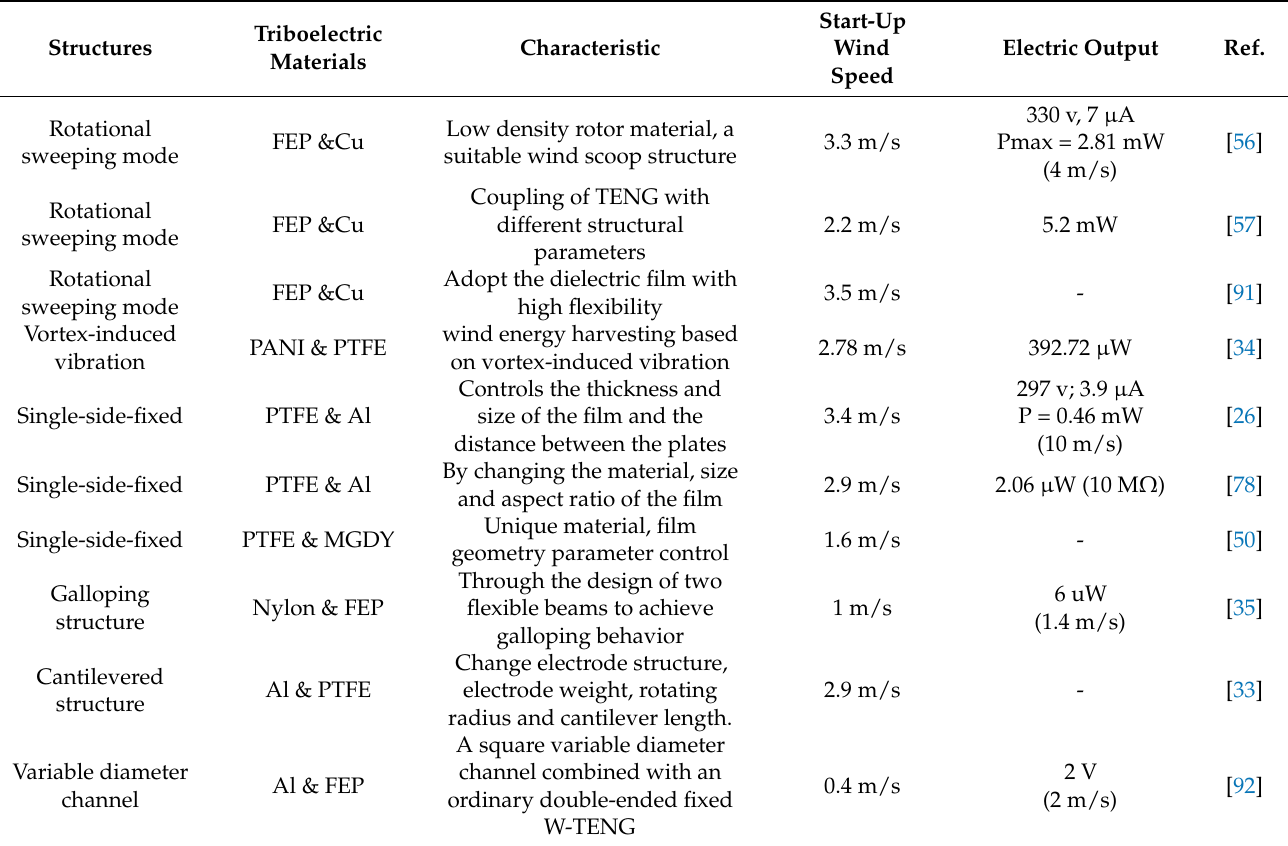
Table 3. Summary and comparison of various WD-TENGs for harvest breeze